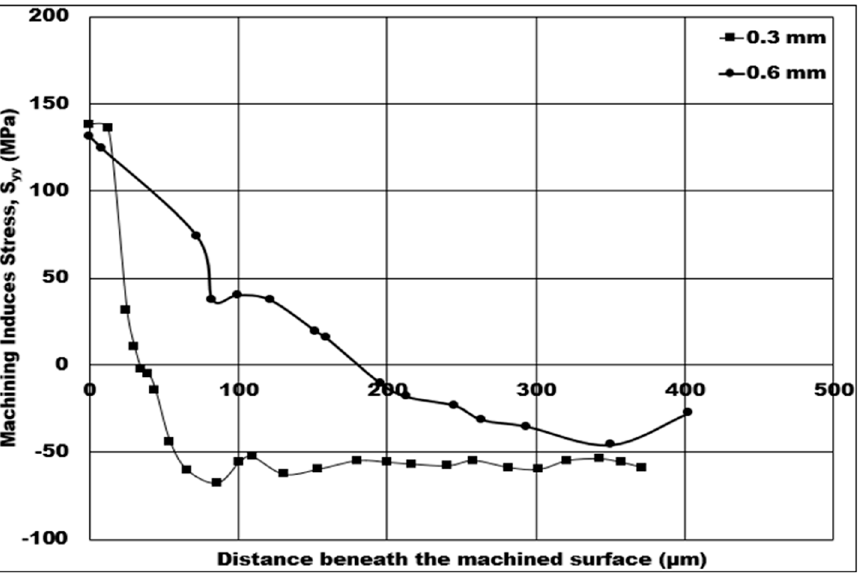
Figure 10. Numerical machining induced stress distribution under the influence of average-sized hollow aluminium oxide bubbles (10% volume fraction, cutting speed = 50 m/min, uncut chip thickness = 0.07 mm, dry cutting).